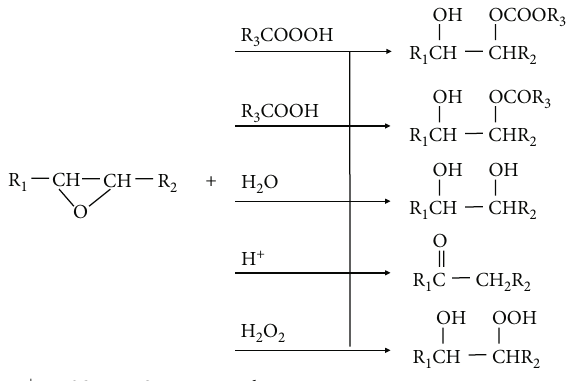
Figure 2: Side reactions of epoxidation in the presence of acidic ion exchange resins